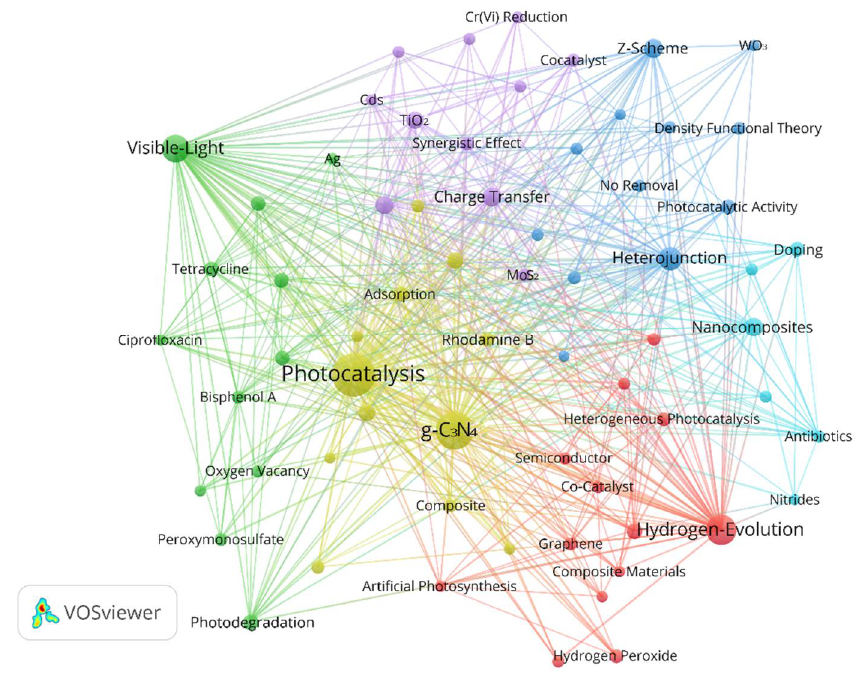
Figure 6. Keywords co-occurrence network of photocatalytic applications of g-C 3 N 4 .